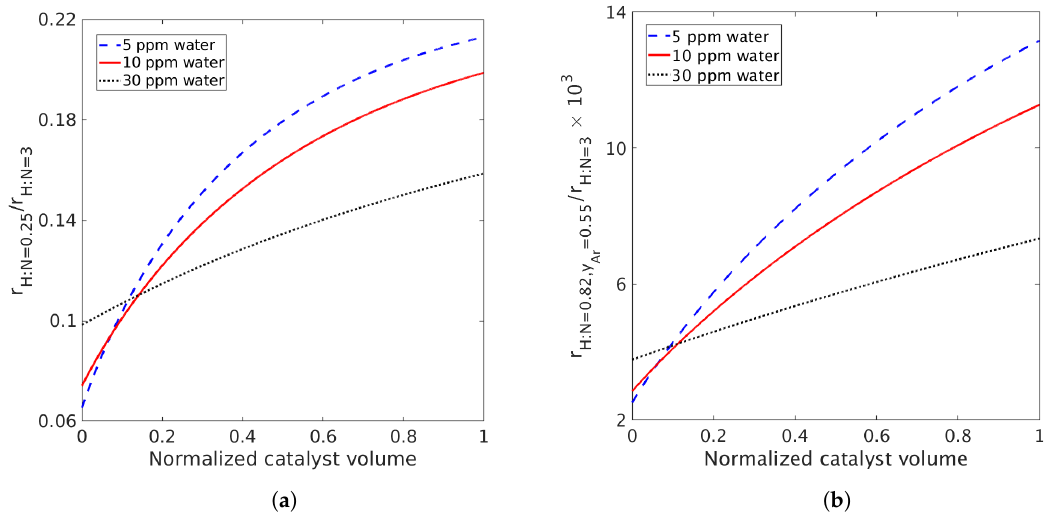
Figure 8. Ratio of reaction rate for the gas stream with only nitrogen ( a ) and both nitrogen and argon ( b ) as compensating gas for offsetting 73% drop in hydrogen supply.